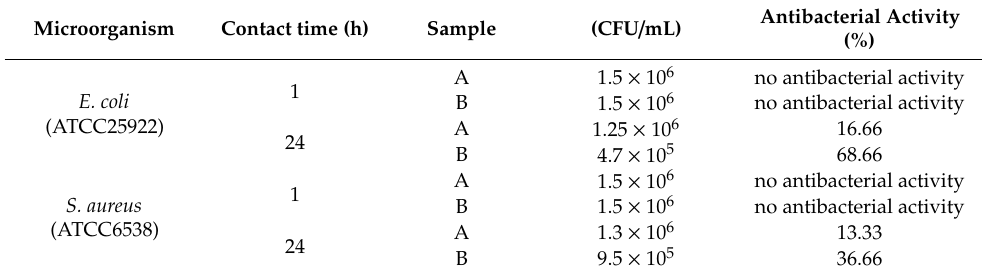
Table 1. Results of antibacterial assay against two bacterium strains for A (pristine PCL) and B